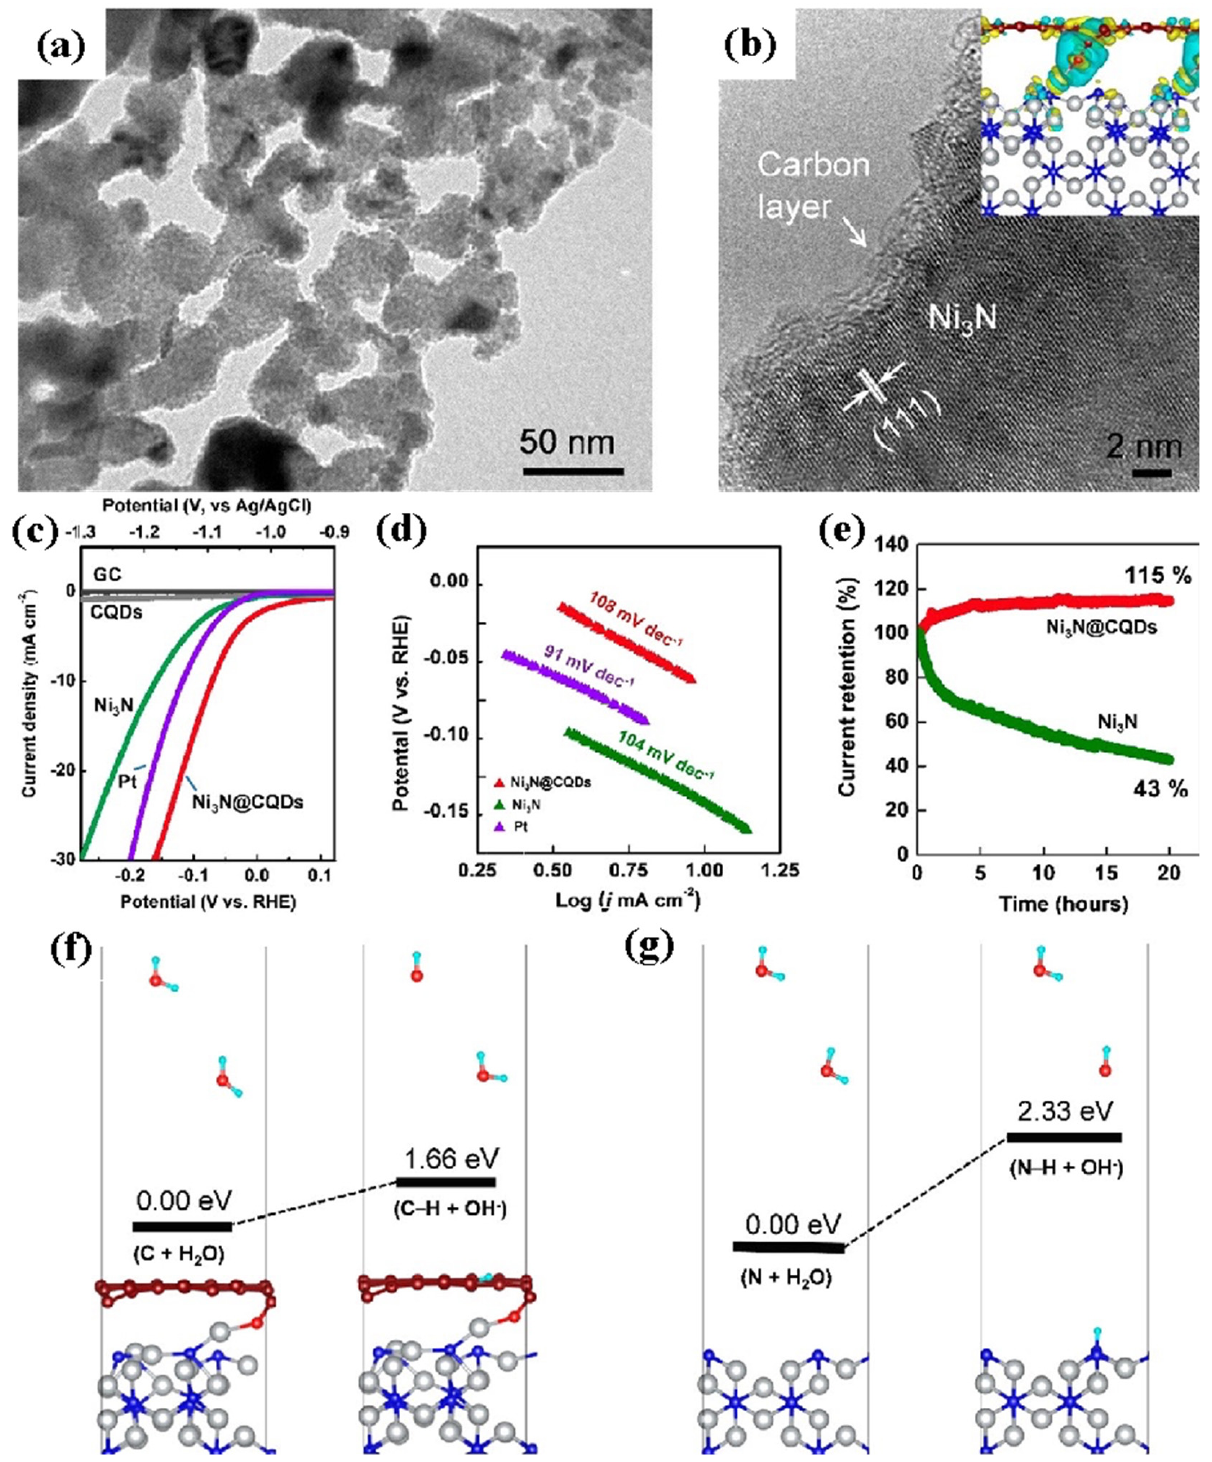
Figure 16. ( a ) TEM image and ( b ) HRTEM image of Ni 3 N@CQDs. ( c ) LSV polarization curves of Ni 3 N@CQDs in comparison with a platinum (Pt) electrode, pristine Ni 3 N, CQDs and a glassy carbon (GC) electrode in a 1 M KOH aqueous solution. ( d ) Tafel slopes. ( e ) Normalized HER amperometric I-t curves of Ni 3 N@CQDs and Ni 3 N at a constant overpotential of 77 mV ( − 1.1 V vs. Ag/AgCl). ( f , g ) Comparison of the HER Volmer reaction step and the resultant binding energies on ( f ) carbon- coated Ni 3 N(110) and ( g ) pristine Ni 3 N(110) surfaces. Reprinted with permission from Ref. [83]. Table 2. Comparison of HER performance for Ni-based electrocatalysts. Catalyst Material Current Density Overpotential for HER Electrolyte Reference NiMo nanowire arrays